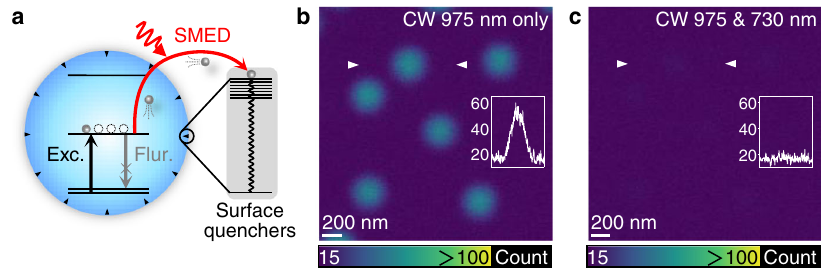
Fig. 1 | The surface-migration emission depletion (SMED) strategy enables optical depletion of NaGdF 4 :Yb/Tm nanoparticles. a The proposed SMED mechanism underlying emission depletionrelies on an externalenergy source and bypasses fundamental constraints imposed by conventional STED microscopy. b , c Emission depletion of single NaGdF 4 :Yb/Tm (18/0.3%) nanoparticles under dual-beam CW laser manipulation (975-nm excitation and 730-nm de-excitation).